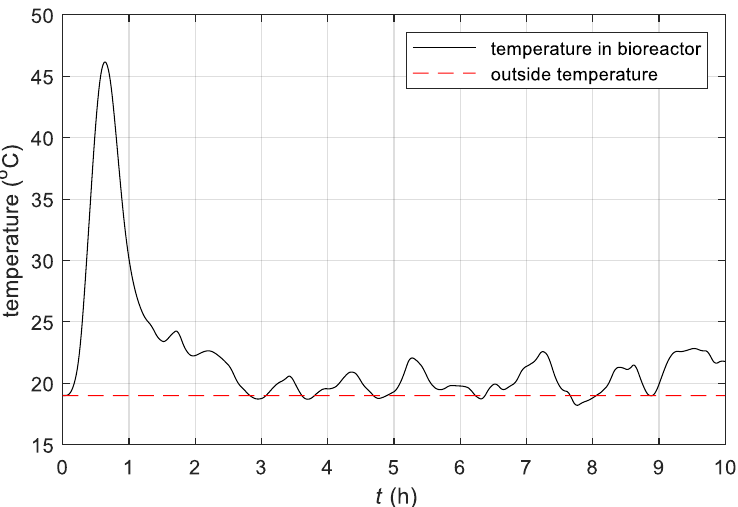
Figure 11. Time response of the temperature of the original fermentation process in the batch bioreac- tor and the constant outside temperature when the simple adaptive control was used, corresponding to Figure 10.